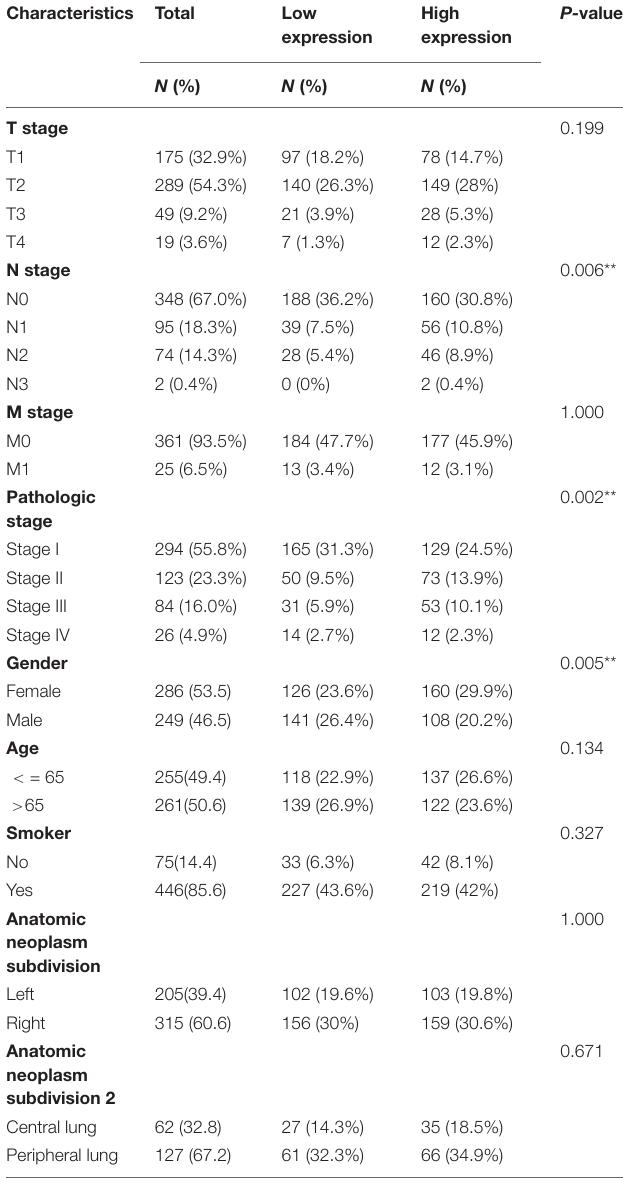
TABLE 1 | Clinical characteristics of the lung adenocarcinoma patients (TCGA). Characteristics